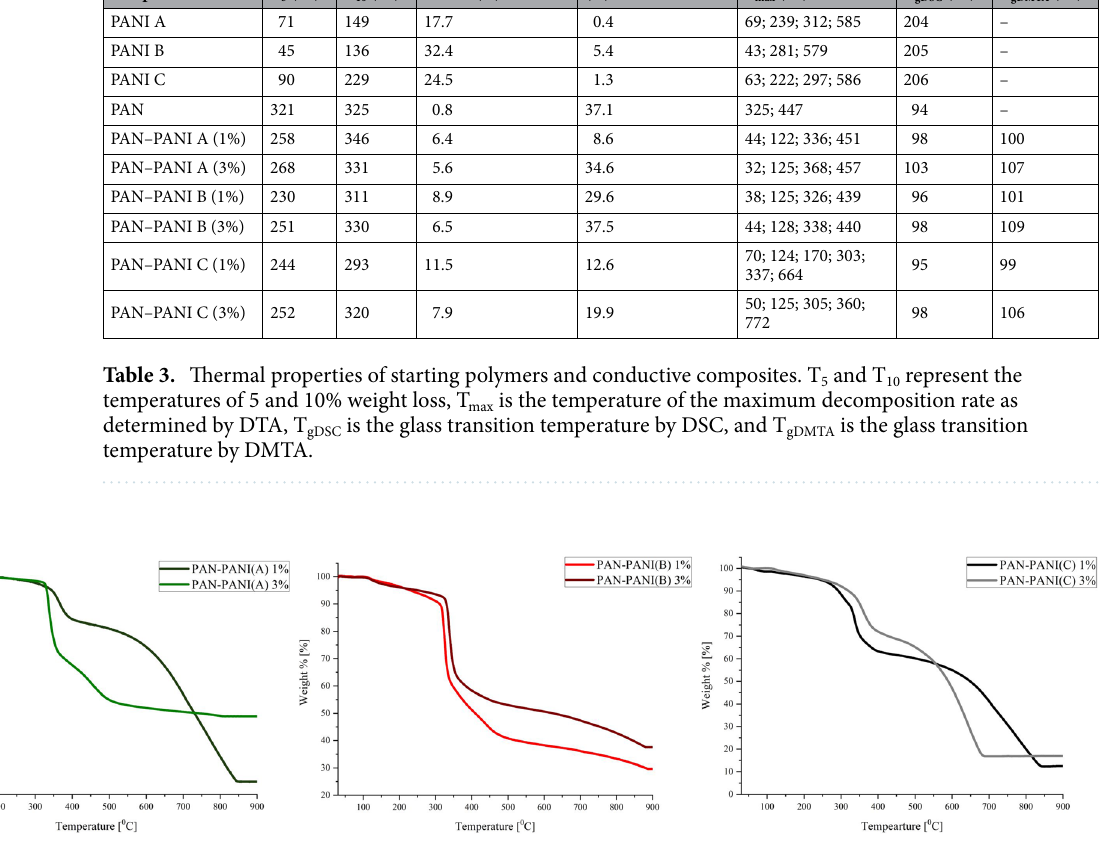
Figure 4. Thermogravimetric thermographs of the representative